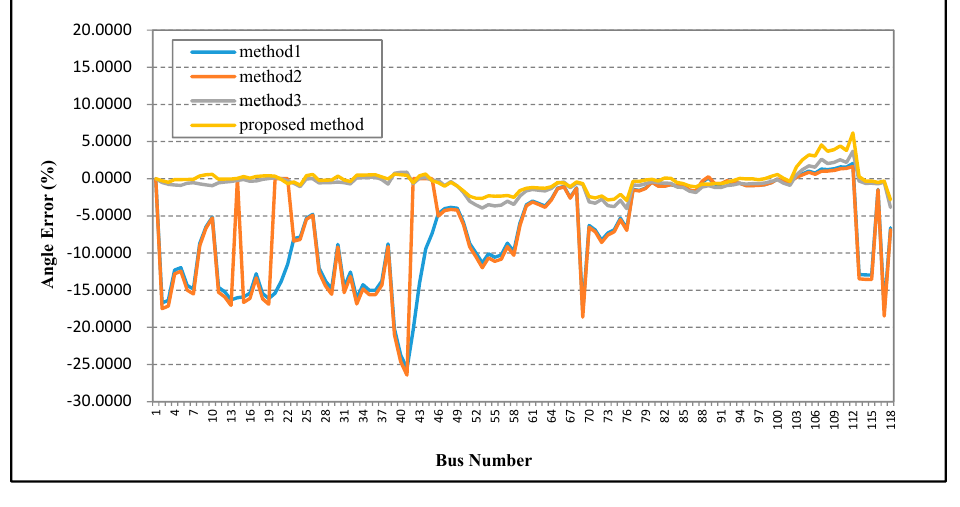
Figure 19. The percentage of bus voltage angle estimate error in 118 bus system. Table 8. The results of state estimation of four methods in 118 bus system.